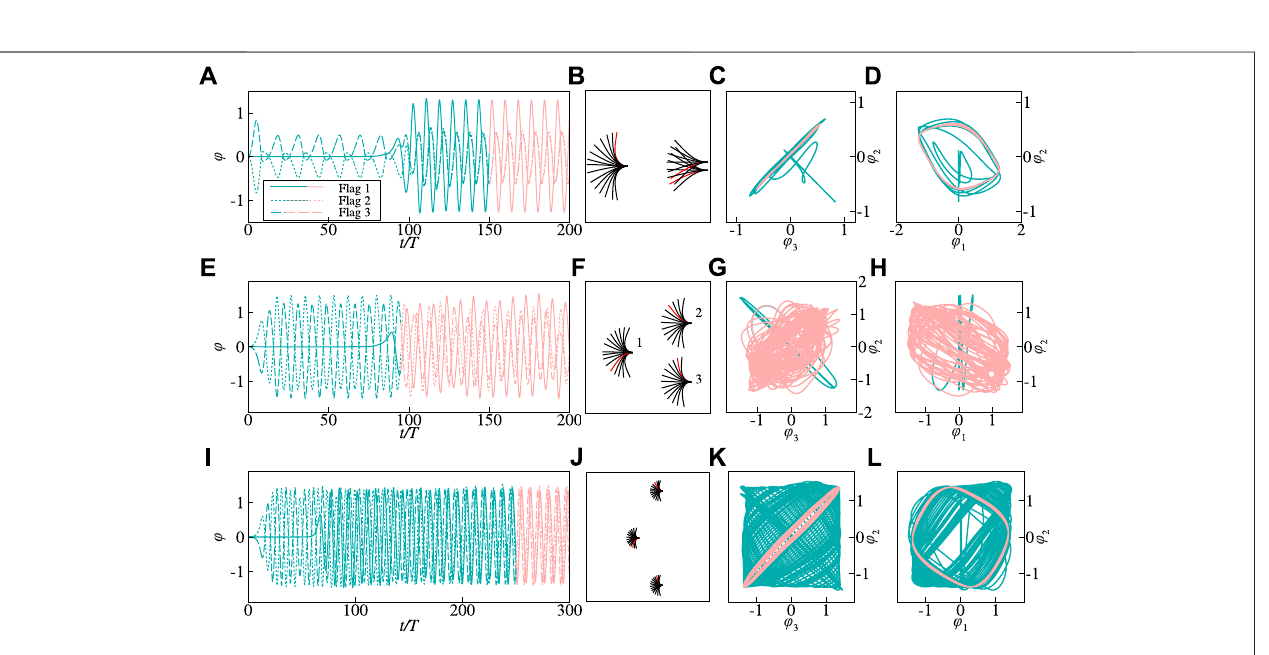
FIGURE 6 | Time history of the instantaneous fl apping angle φ (A,E,I) , the superimposed views of the fl ags (B,F,J) , and the phase trajectories in φ 3 − φ 2 plane (C,G,K) and φ 1 − φ 2 ( d , h , l ) plane for distinct modes in left triangle con fi gurations, i.e., regular-coupled (RC) mode with G =1, H =0.2 (A,B,C,D) , irregular-coupled (IC) mode with G =1, H =2 (E,F,G,H) and decoupled (DC) mode with G =1, H =8 ( I , J , K , L ) . The other governing parameters are as follows: Re =200, M =2.9, K =0.3 and S =1,000. Flag 1 represents the front fl ag, and Flag 2 and 3 represent the rear upper and lower fl ags, respectively. The red beams in the second column fi gures represent the instantaneous position of the fl ags at a certain instant. The phase diagrams have been colored to represent time, with the curve being initially green and shifting to red as time